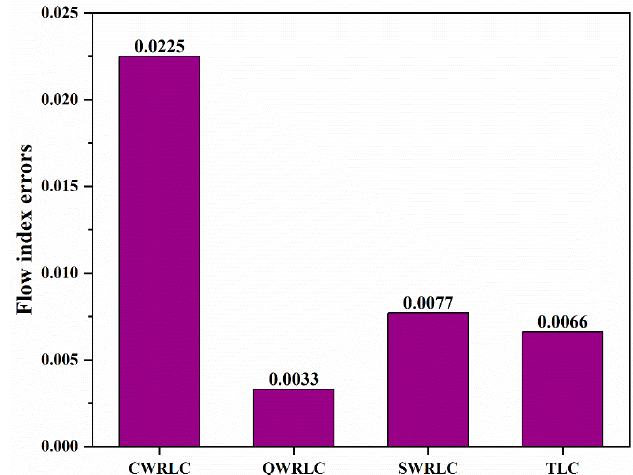
Figure 14. The histogram of the flow index errors of the four emitters.